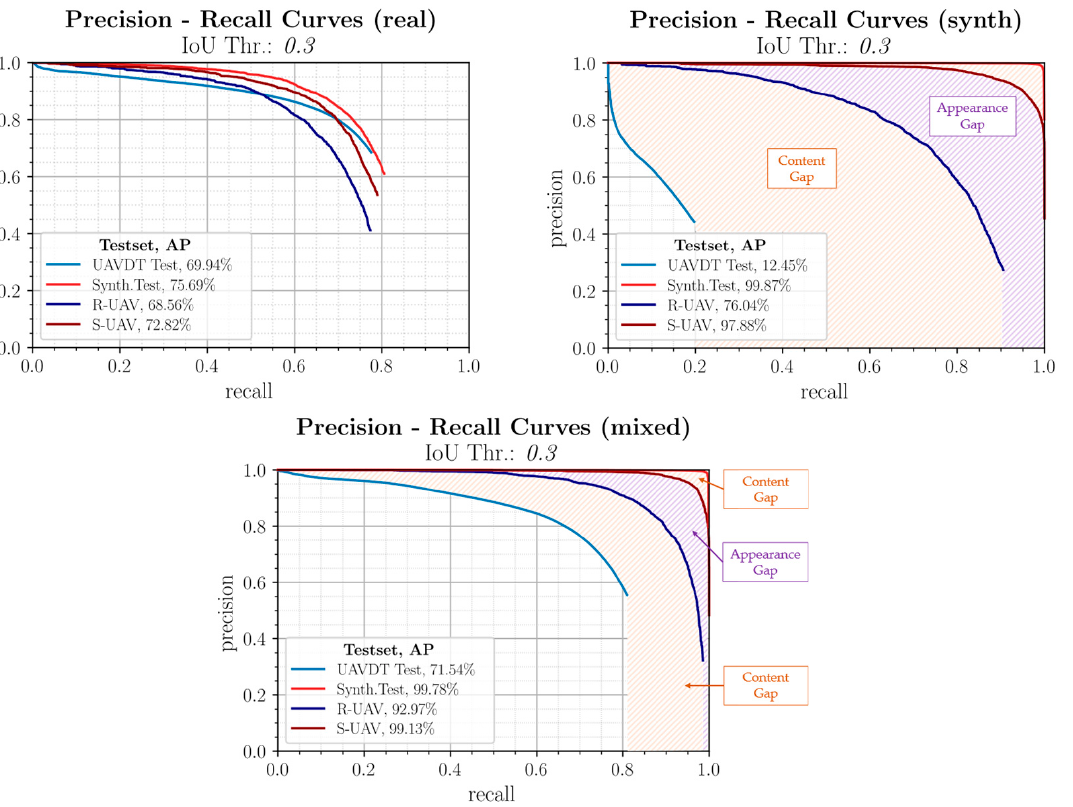
Figure 10. PR curves comparing the detection performances for the training configurations (real, synthetic, mixed) on the associated test datasets (UAVDT, Synth. Test) and the content-equivalent real and synthetic image pairs (R-UAV/S-UAV). The corresponding Average Precision (AP) is given in the legend.